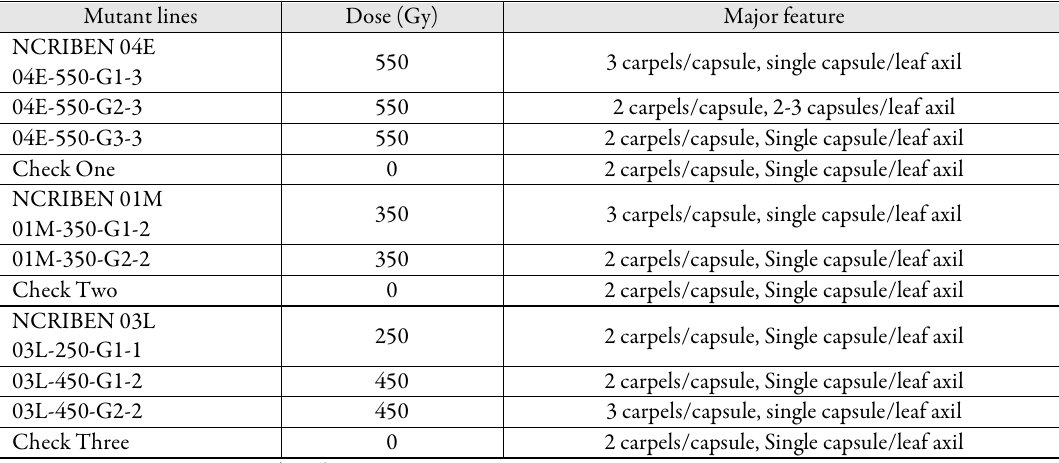
Table 1. Parental stock and main characters of M 3 lines Mutant lines Dose